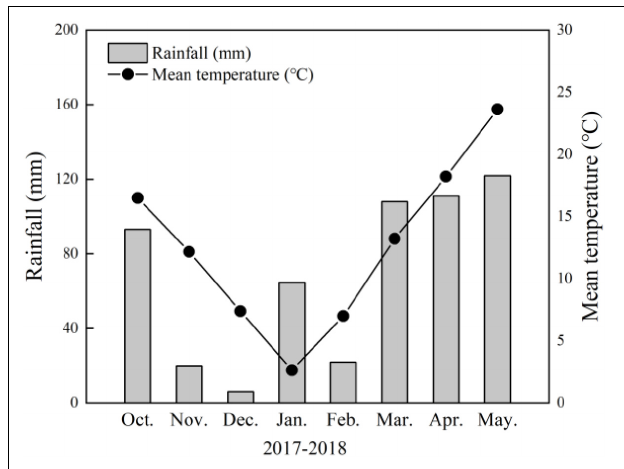
FIGURE 1 | Monthly total rainfall and monthly mean temperatures recorded on-site in 2017–2018 wheat-growing seasons in Jingzhou, Hubei Province, China.